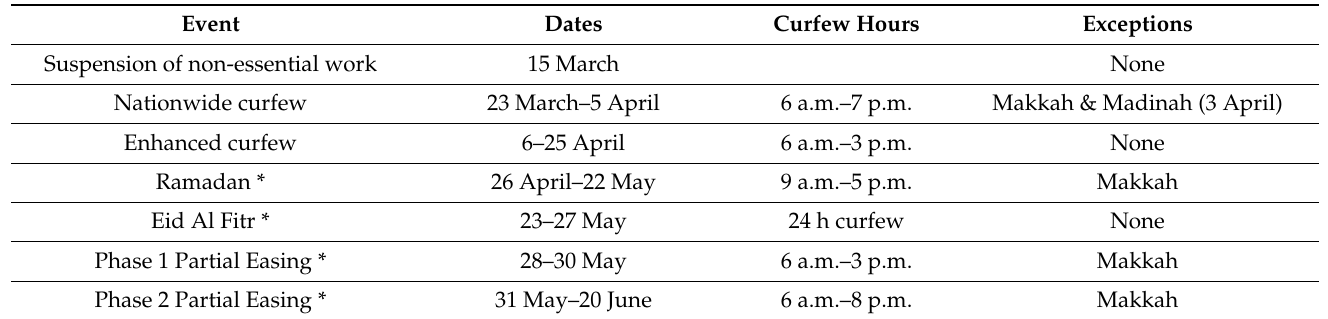
Table 1. Timeline of Events